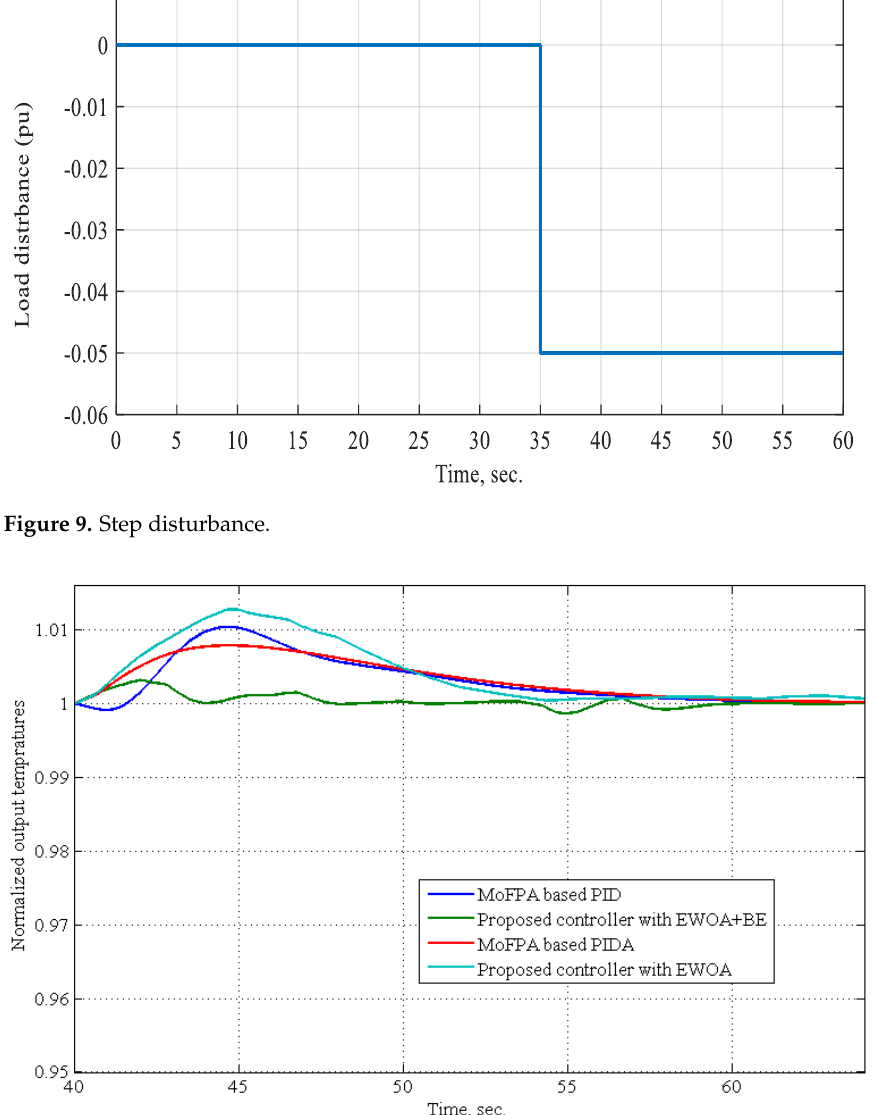
Figure 10. System dynamic performance of the third scenario.